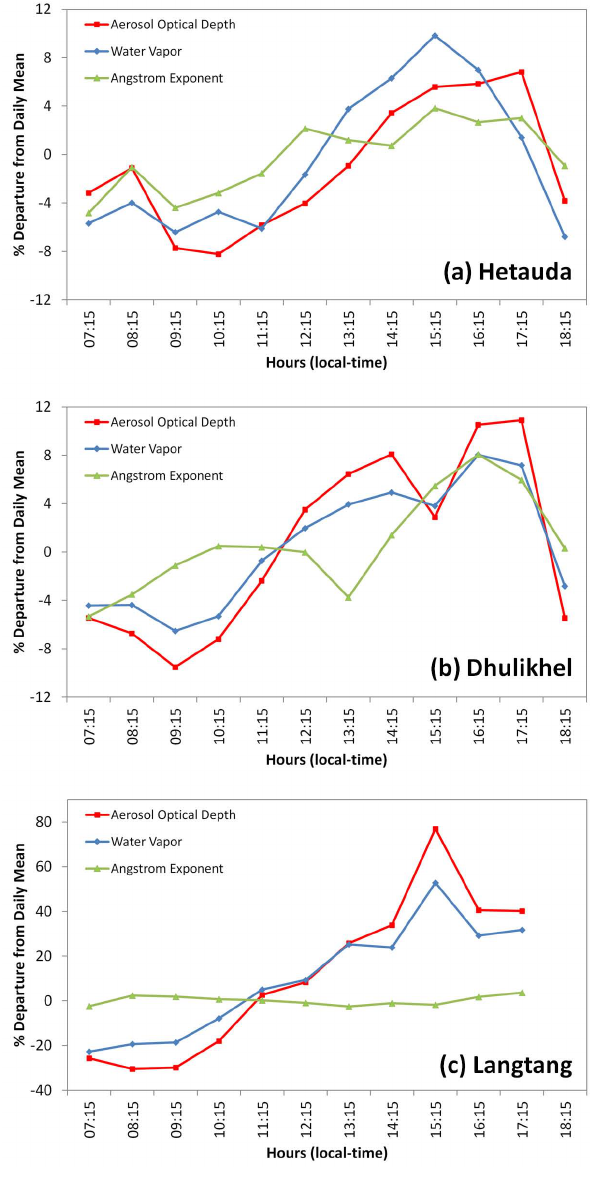
Fig. 9. Diurnal variability of column integrated aerosol loading (AOD), water vapor and Angstrom Exponent over three transect lo- cations in Nepal (a) Hetauda (foothill), (b) Dhulikhel (slope-valley) and (c) Langtang (elevated site). Diurnal variability is calculated from CIMEL sunphotometer data and is represented by calculating hourly percentage departure of the three variables from their daily mean values. A characteristic afternoon peak in AOD and water va- por is observed at all sites associated with the enhanced convection and upslope transport of